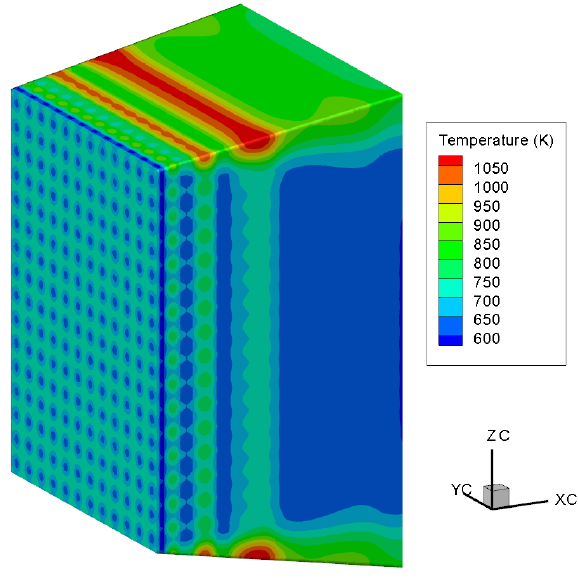
Figure 4. The temperature contour of the whole blanket.